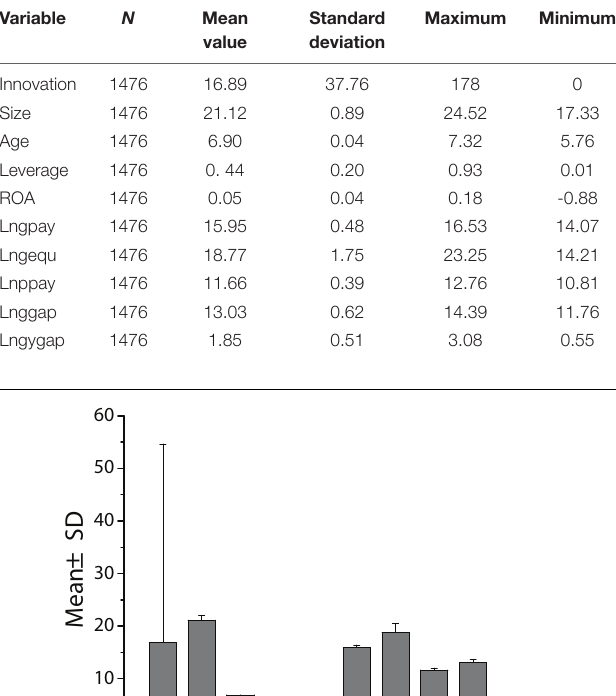
TABLE 2 | Descriptive statistics of each variable.